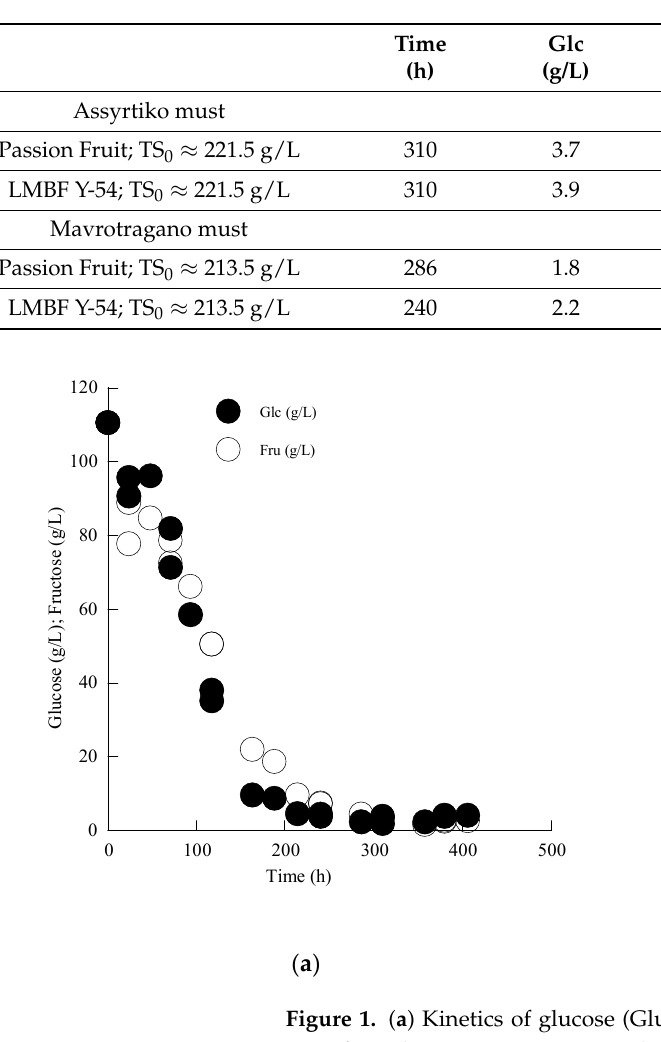
Table 2. Experimental results originated from kinetics of S. cerevisiae LMBF Y-54 and Passion Fruit growing on Assyrtiko and Mavrotragano must at points when a maximum concentration of ethanol (EtOH max ) was achieved. Representations of residual glucose (Glc, g/L), residual fructose (Fru, g/L), total sugars consumed (TS cons , g/L), ethanol produced (EtOH, g/L) and ethanol conversion yield per total sugars consumed ( Y EtOH/Glc , g/g). Each experimental point is the mean value of 2 independent measurements (SE for most experimental points ≤ 17%).